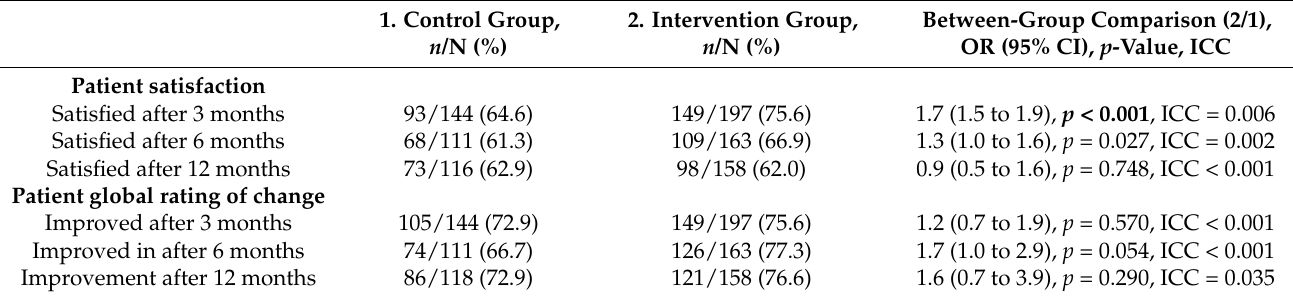
Table 5. Comparisons of patient reported experience measures in control and intervention group. 1. Control Group,